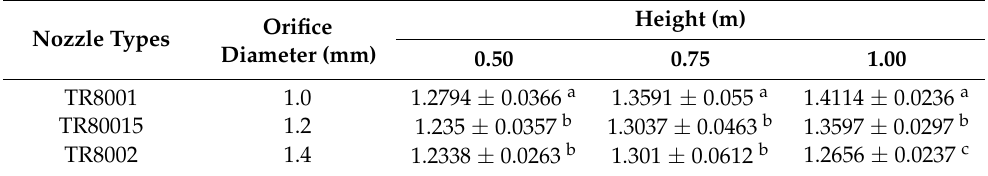
Table 3. Effect of the orifice diameters on